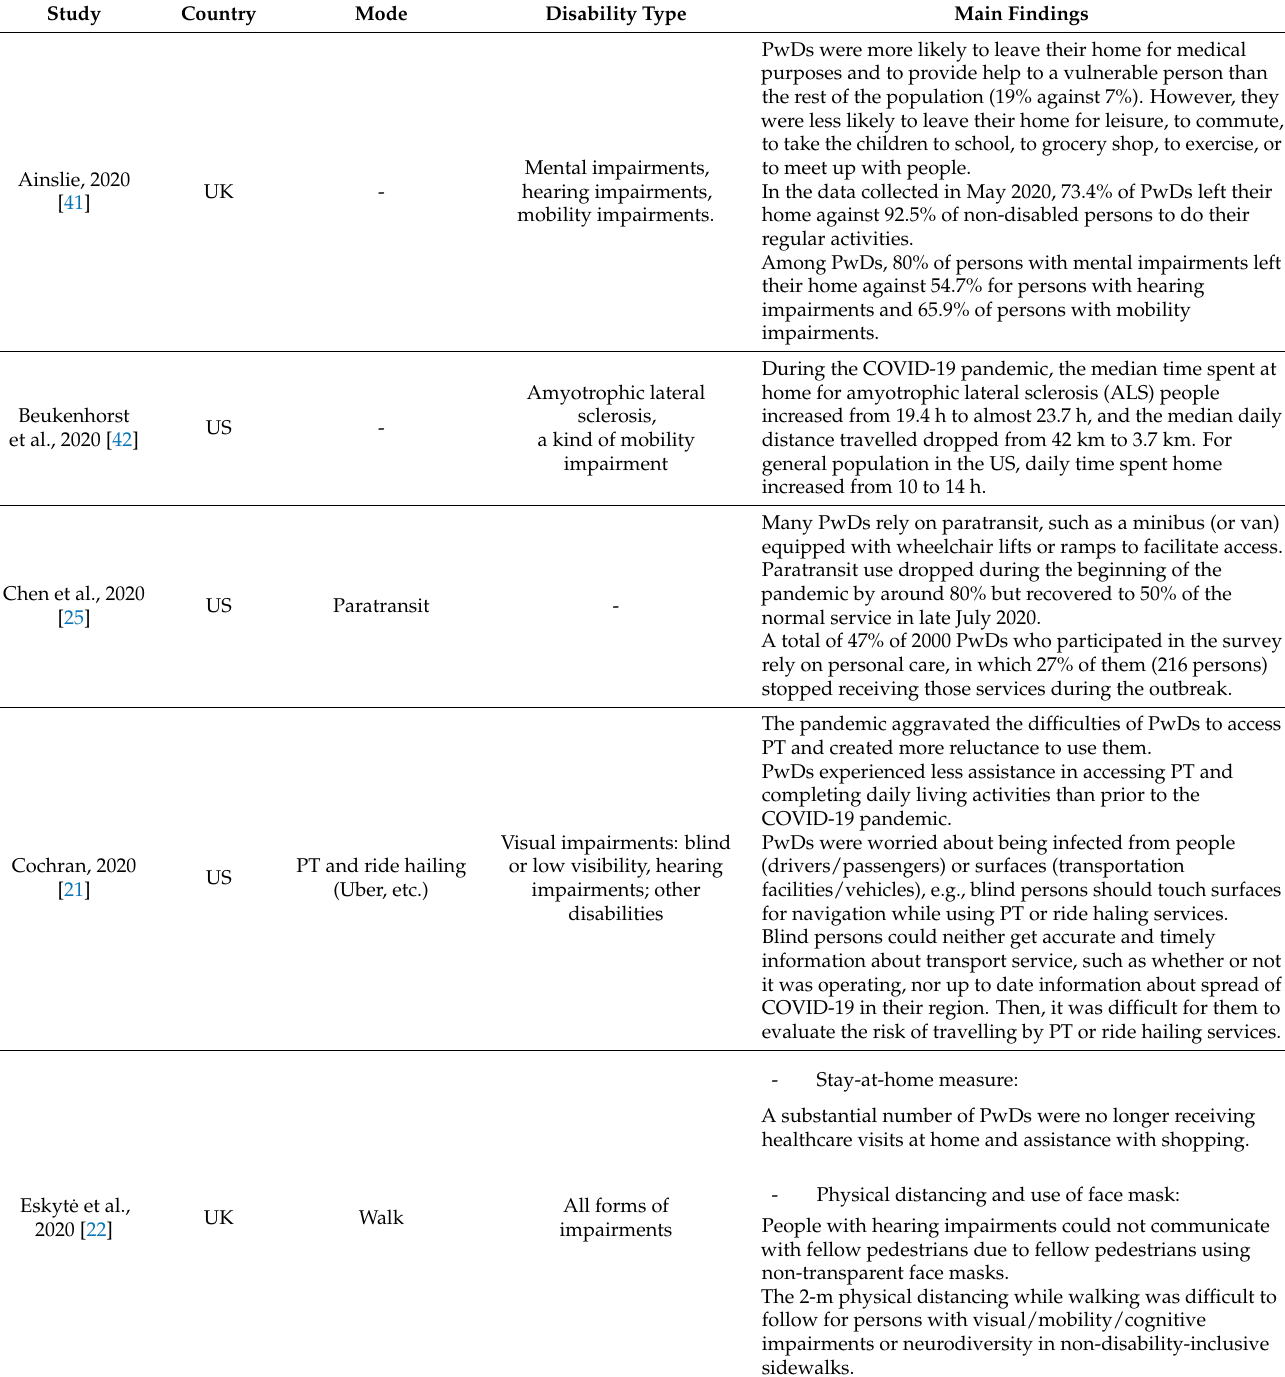
Table 2. Reviewed studies related to COVID-19 impacts on the mobility and activities of disabled